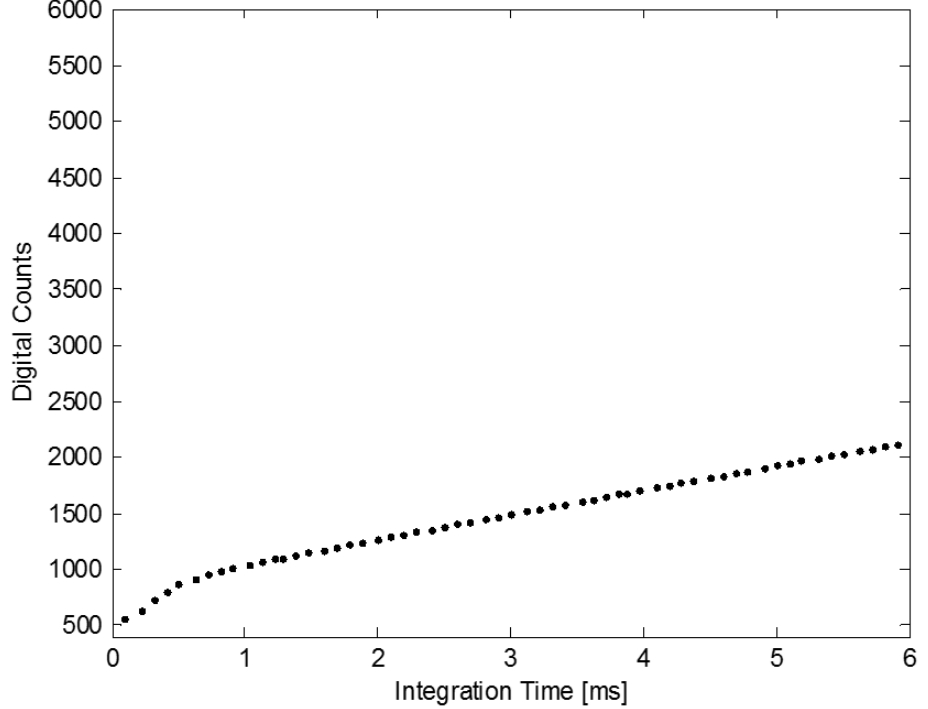
Figure 3. Integration time sweep data for one detector. Three regions are noticeable in the data: a lower linear gain region, an upper linear gain region and a non-linear transition region between the two linear